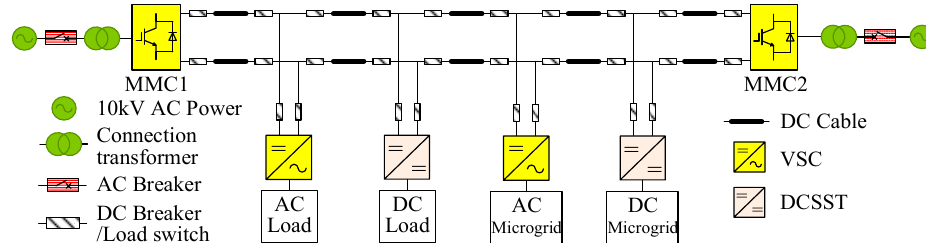
Figure 1. Topological structure of the ±10 kV VSC-DC distribution system.